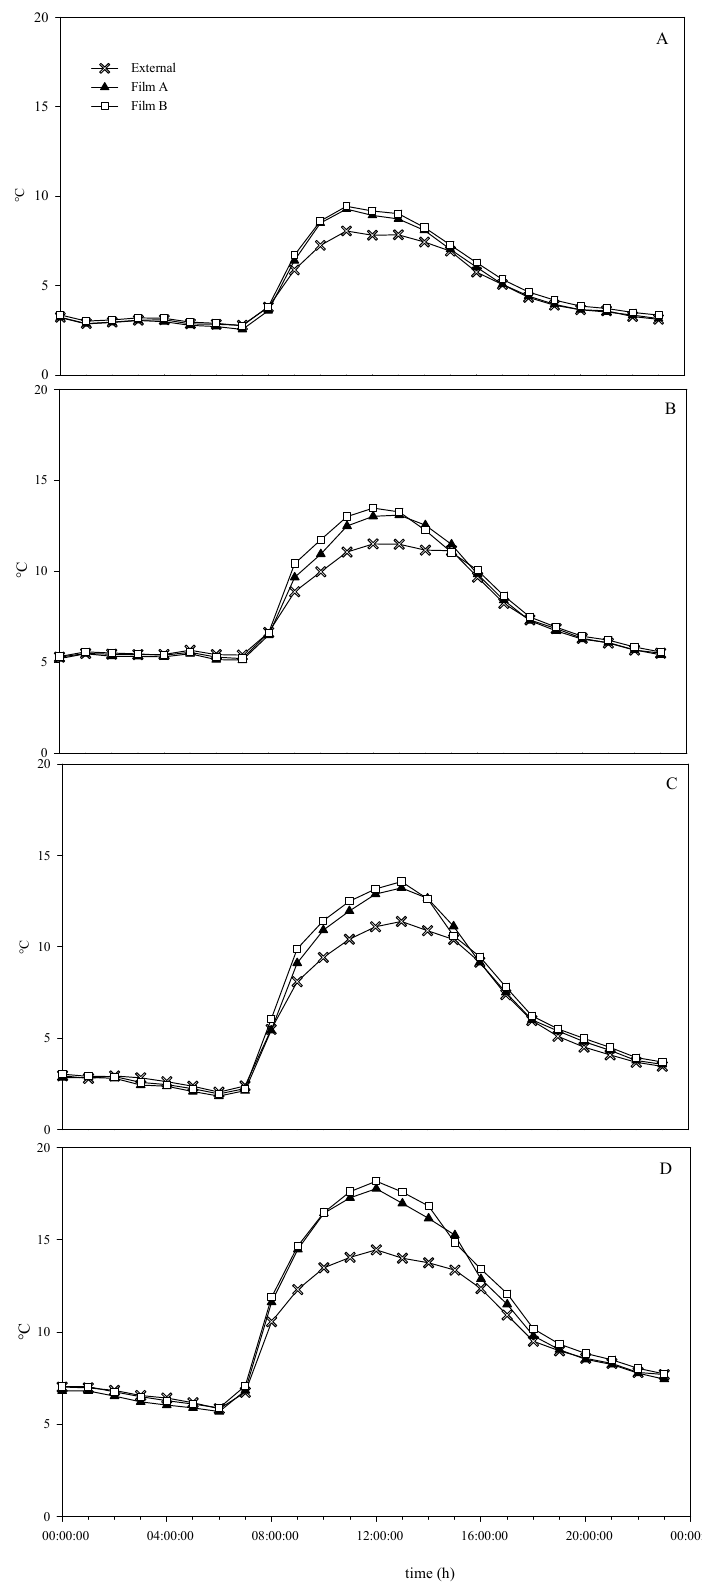
Figure 2. Hourly day mean value of temperature during the growing period of spinach referred to 15-day intervals starting from sowing (A = 1–15 days; B = 16–30 days; C = 31–45 days; D = 46–60 days).